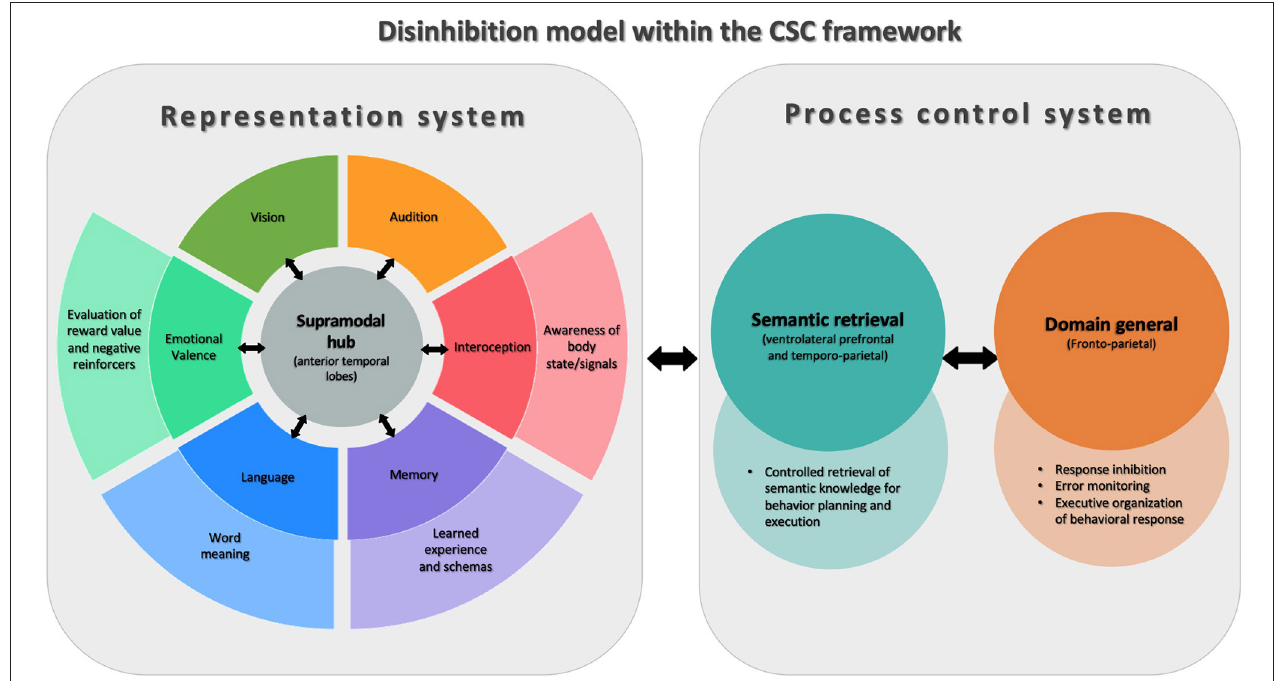
FIGURE 1 | Model of disinhibition conceptualized via Controlled Semantic Cognition theory (CSC). This figure shows the two interconnected systems that are part of the CSC theory. On the left of the figure is the representational system, whose function is to acquire and store conceptual knowledge. For this, in the center, there is a supramodal semantic hub (anterior temporal lobes) that receives modality-specific information from different systems (“spokes”) throughout the brain. On the right is the process control system, involved in the successful application of conceptual knowledge, composed of semantic retrieval and general domain processes. The figure shows how components of the CSC system support different aspects of cognition that are involved in behavioral inhibition and